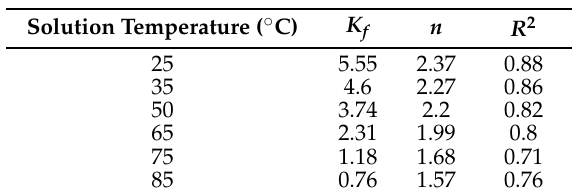
Table 2. Estimated parameters of the Freundlich isotherm for copper ions’ sorption onto MANSG at different solution temperatures.